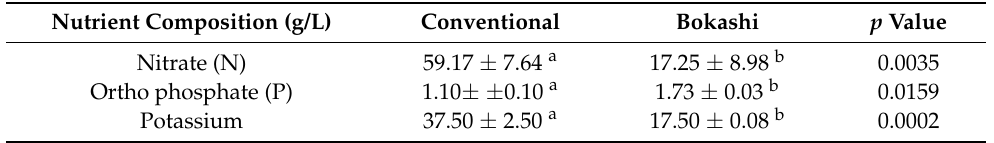
Table 3. Nitrate, phosphate and potassium levels in the sap of the matured leaves of bell pepper plants grown by conventional and bokashi